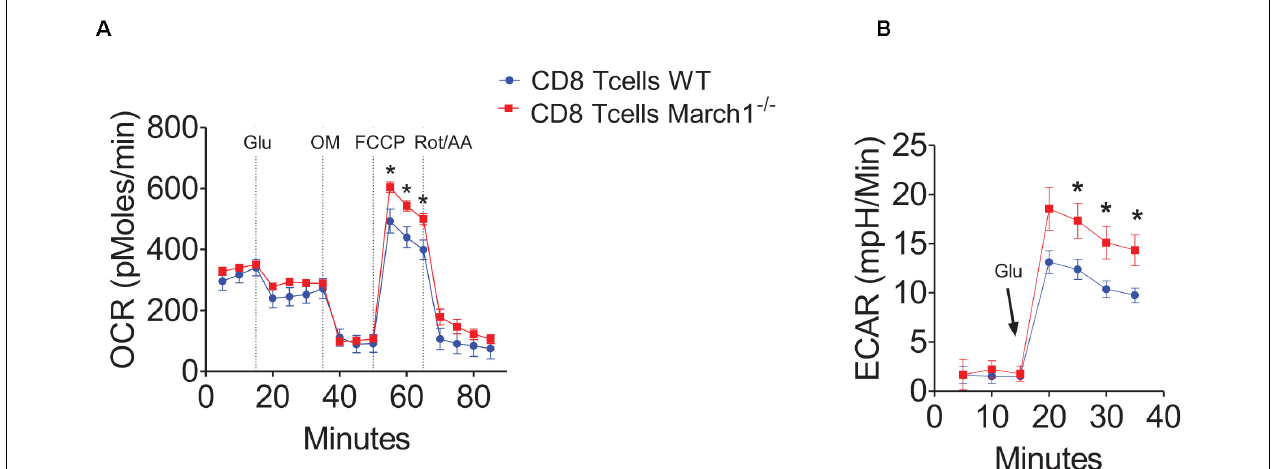
FIGURE 7 | March1 deficiency impairs the metabolic activity of CD8 + T cells. Splenic CD8 + T cells were purified from March1 KO and WT mice and analyzed using XF24 Seahorse analyzer. (A) Spare respiratory capacity measured by oxygen consumption rate (OCR) of naïve CD8 + T cells in the presence of glucose (Glu) after Oligomycin (OM), FCCP and Rotenone + Antimycin A (Rot/AA) injection. (B) Glycolysis measured by extracellular acidification rate (ECAR) of anti-CD3/anti-CD28 activated CD8 + T cells after supplementation with glucose (Glu). Experiments were performed using cells from a minimum of two mice and repeated three times with similar results. ∗ P <